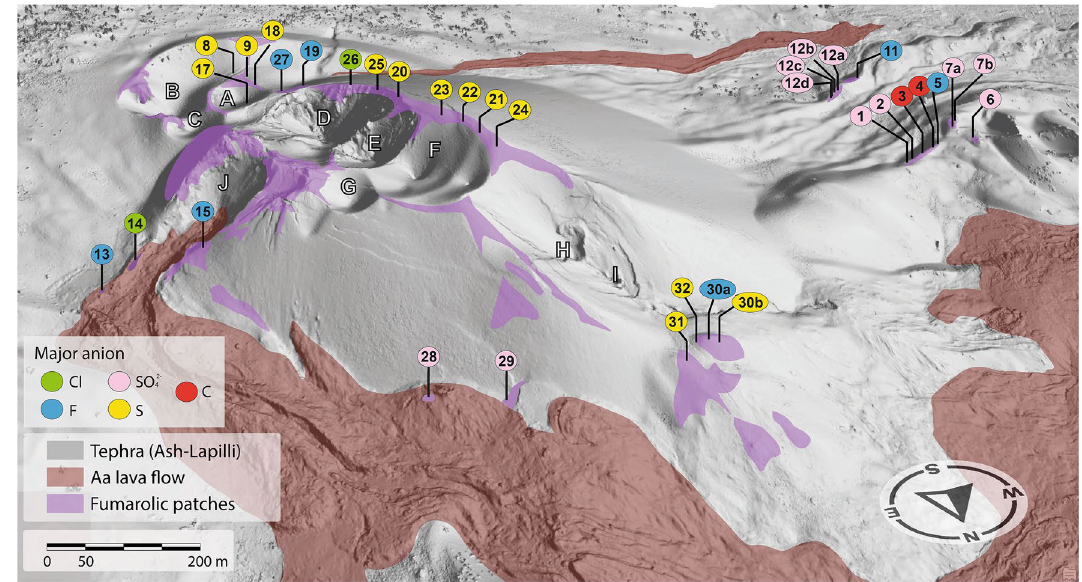
Figure 2. Northern 3D view of the Tajogaite volcano cone. Major mineralization patches related to fumarole activity are highlighted in purple. Individual craters are labelled by letters (A–J) and samples by numbers (1–32). The Digital Elevation Model has been modified from Cívico et al. 29